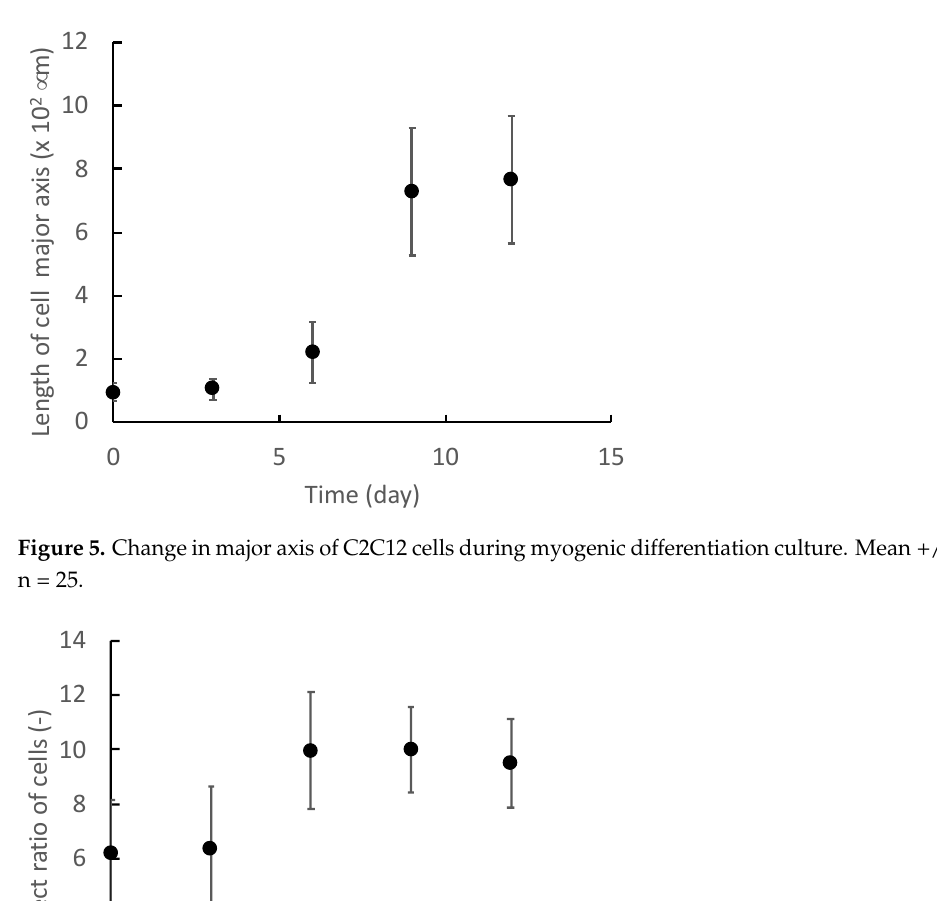
Figure 4. Microscopic images of C2C12 cells during myogenic differentiation culture.